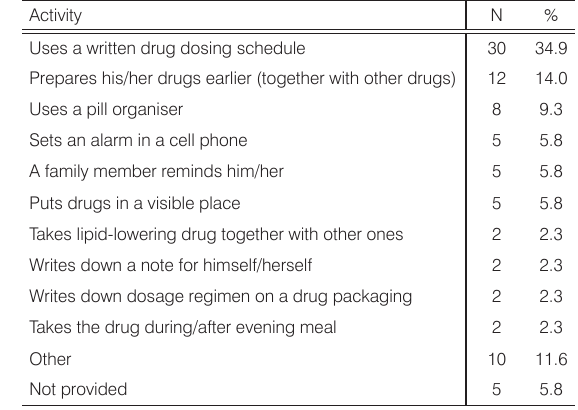
Figure 1. Admitted adherence to lipid-lowering treatment in studied subjects. Table 2. Activities adopted by patients in order to remind them about taking medication in the evening #$